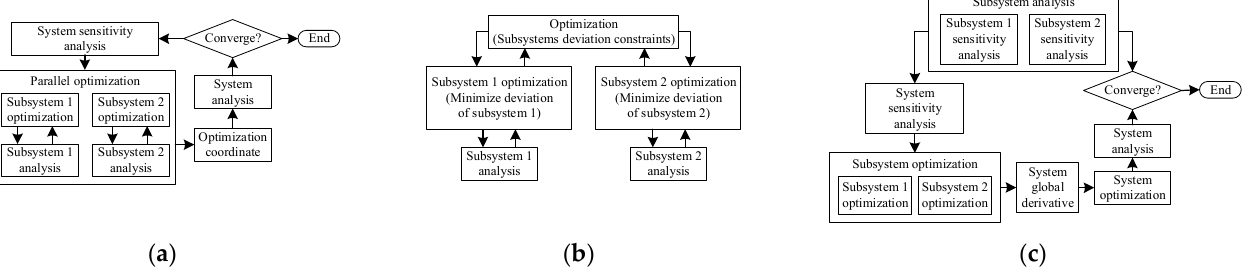
Figure 1. Frameworks of traditional multi-level MDO methods: ( a ) CSSO; ( b ) CO; ( c ) BLISS.